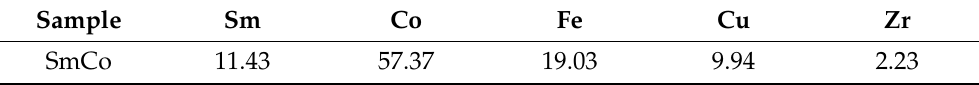
Table 1. Chemical compositions of the Sm(Co, Fe, Zr, Cu) 7.8 sample used in this study